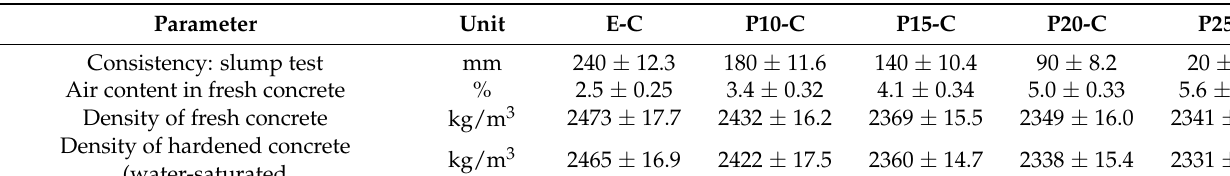
Table 5. Physical properties of fresh and hardened concrete.